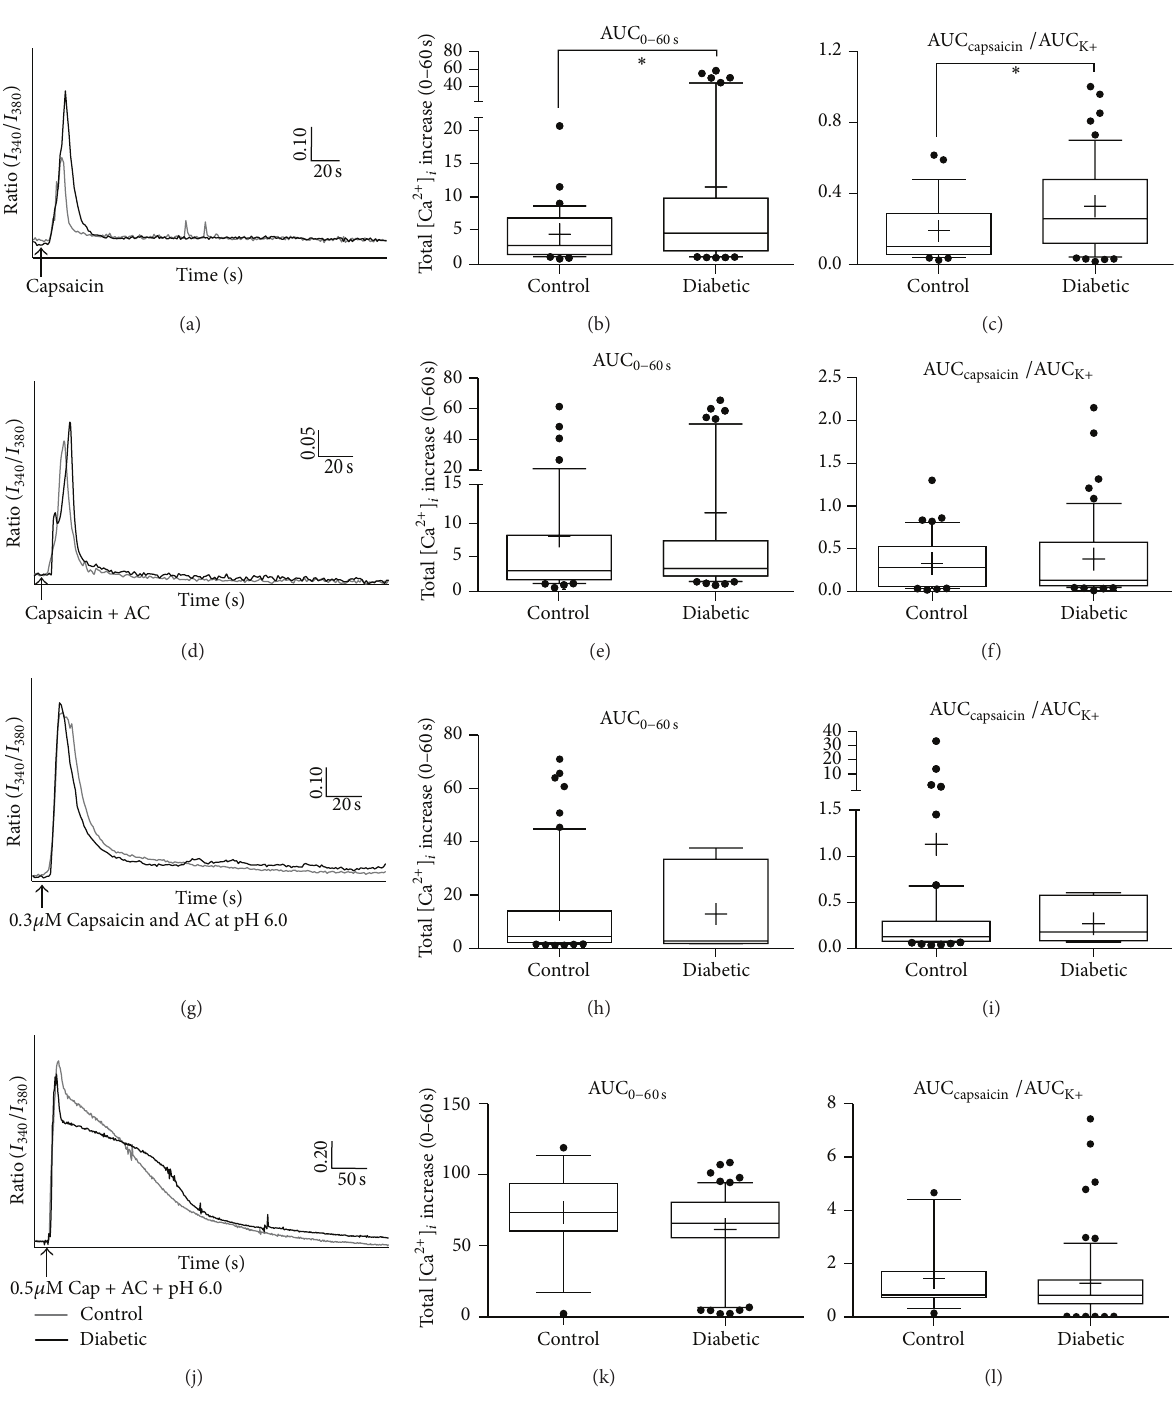
Figure4:Tracesandboxplotsfromcapsaicinexperiments.Panels(a),(d),(g),and(j)showtraces(examples)ofthetime-[Ca 2+ ] 𝑖 development for control and diabetic dorsal root ganglion neurons. The arrows indicate the onset of 10sec stimulation with (a) capsaicin, (d) combination of Capsaicin and algogenic chemicals (AC); (g) combination of 0.3 𝜇 M Capsaicin and AC at pH 6.0, and (j) 0.5 𝜇 M Capsaicin and AC at pH 6.0. The traces were background corrected. As a measure of [Ca 2+ ] 𝑖 , the vertical axis is shown as the 340/380 nm light intensity ratio. (a) Vertical scale: 0.10; horizontal scale: 20s, (d) vertical scale: 0.20; horizontal scale: 20s.; (g) vertical scale: 0.10; horizontal scale: 20s., and (j) vertical scale: 0.20; horizontal scale: 20sec. Panels (b), (e), (h), and (k) display box plots on the absolute area under the curve (AUC) derived from stimulation with the in (a), (d), (g), and (j) mentioned capsaicin-containing solutions. Panels (c), (f), (i), and (l) display box plots with median, 25th and 75th percentiles on the relative AUC of the capsaicin-containing solution-derived [Ca 2+ ] 𝑖 increase and the preceding 20mM K + -derived [Ca 2+ ] 𝑖 increase. The error bars indicate the 10th and 90th percentiles. Values below the 10th and above the 90th percentiles are shown as dots. + indicates the mean. ∗ 𝑃 < 0.05